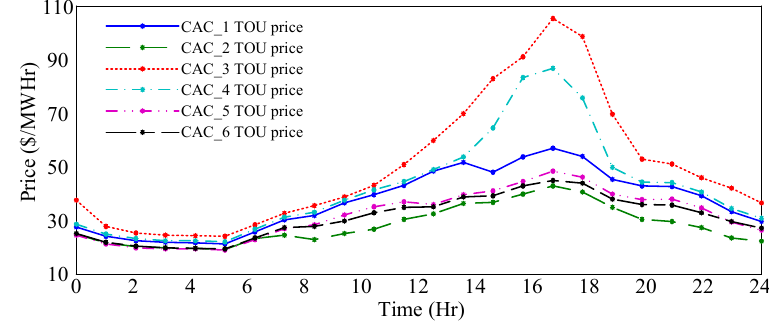
Figure 7. CAC’s time of use (TOU) prices.